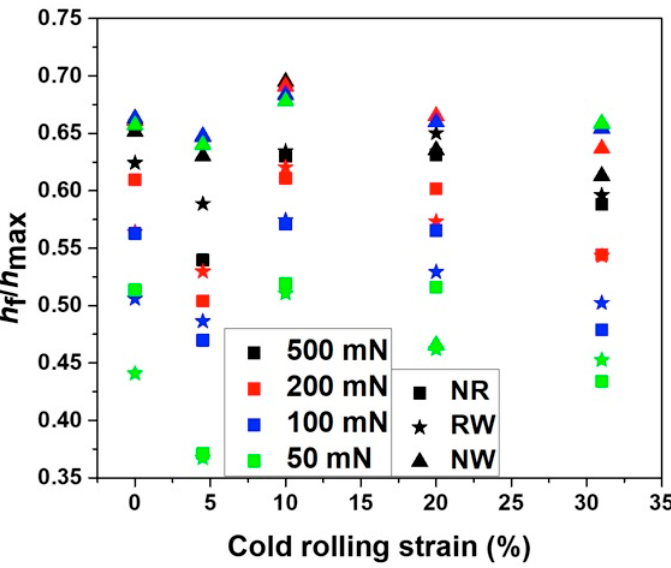
Figure 9. The h f / h max ratio with cold rolling percentage for the NR, RW, and NW planes at P max of 50 mN, 100 mN, 200 mN, and 500 mN. 50 mN, 100 mN, 200 mN, and 500